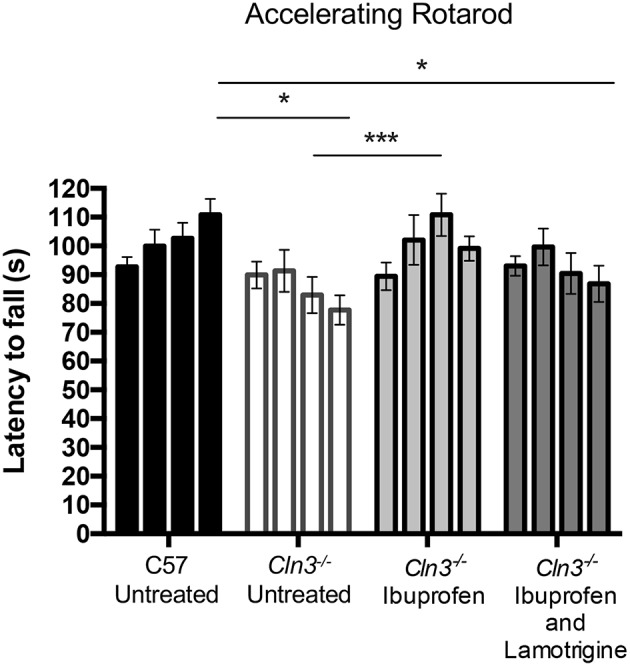
A 3-month treatment with Ibuprofen induces moderate improvement of motor skills in 6–9-month old Cln3−/− mice. An accelerating rotarod (from 0 to 24 rpm in 240 s) was used to measure the motor skills of 6–9-month-old Cln3−/− and wild type (WT) (n = 12) mice. Mice were given either powdered diet with Ibuprofen, Ibuprofen and Lamotrigine, or powdered diet with no drugs (Untreated) (n = 6–7) for 3 months. Data bars represent mean ± S.E.M. of the time (s) mice were able to stay on the rotating rod at 6–9 months of age (0–3 months of treatment). Repeated measures two-way ANOVA was applied with Bonferroni's post-test (*p < 0.05 and ***p < 0.001).